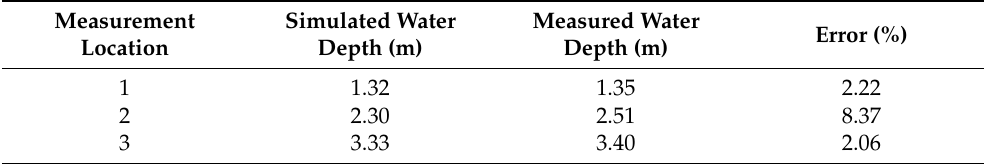
Table 2. A comparison of the water depth from the HEC-RAS simulation and the measured values during our visit to Hurley.